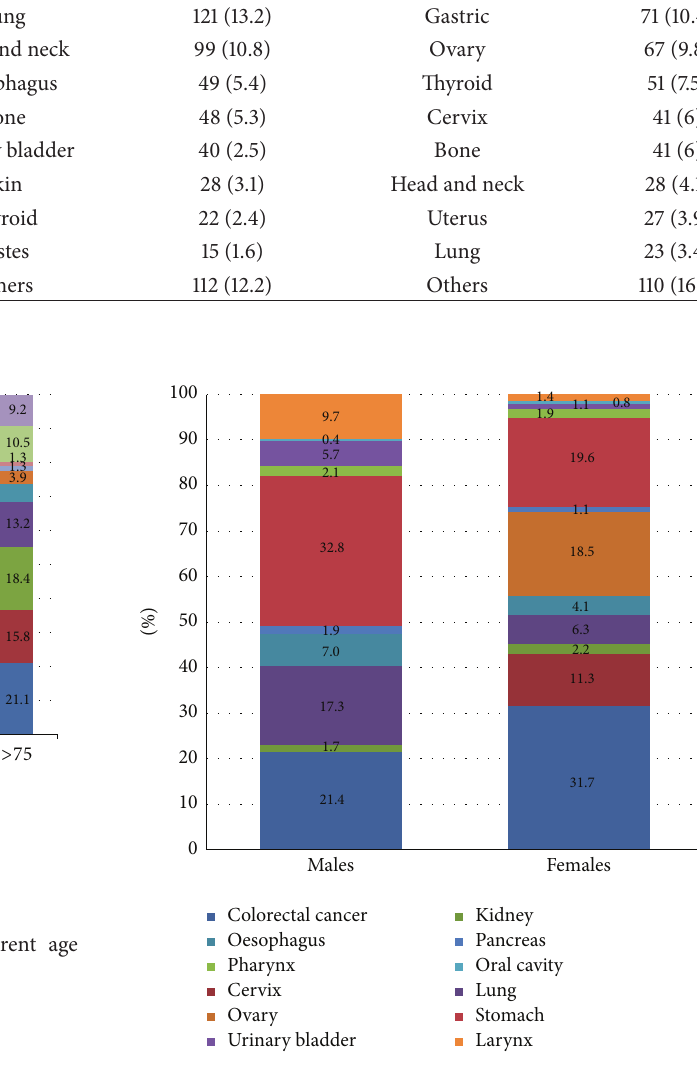
Figure 2: Stack (100%) diagram showing proportion of specific tobacco related sites relative to all tobacco related cancers (2005–